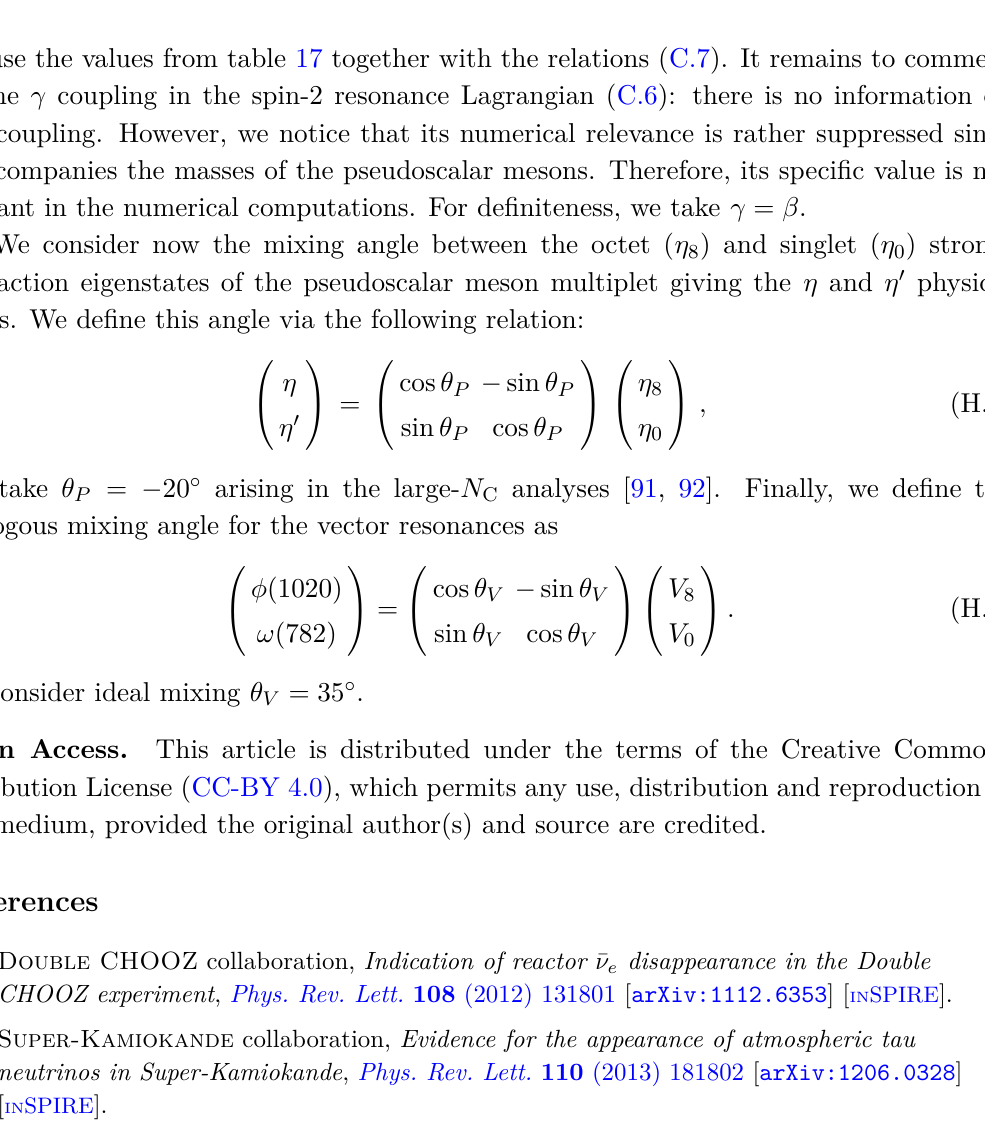
Table 17 . Couplings involving hadron resonances. Their justification is based on the quoted references. For the value of T V see the discussion at the end of appendix